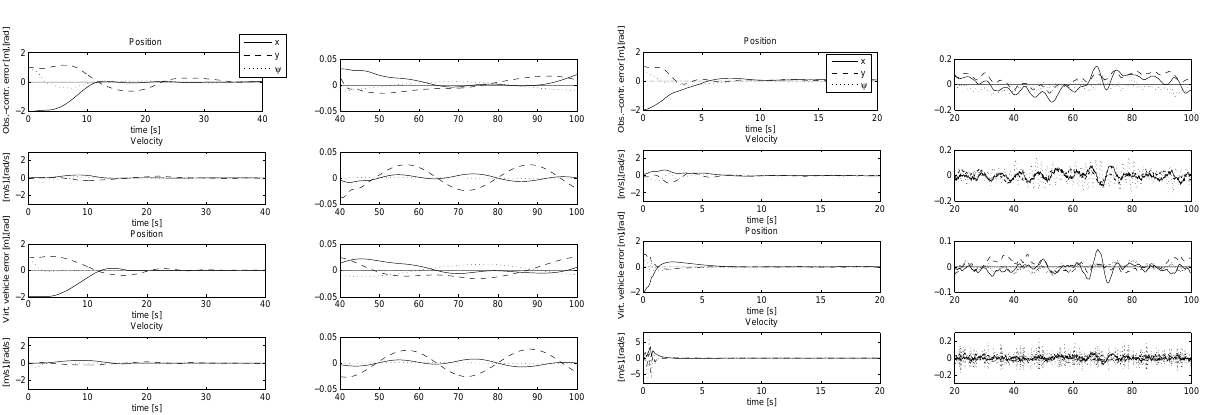
Figure 8: Performance of the dynamic observer scheme (top two rows) and kinematic observer scheme (bot- tom two rows) subject to actuator limitations of 2 N in surge, 1 . 5 N in sway and 1 . 5 Nm in yaw.